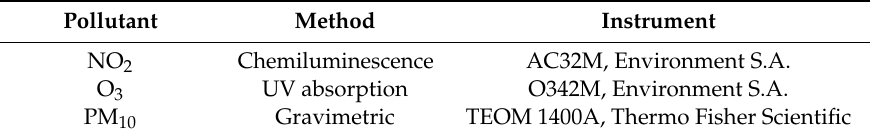
Table 1. Description of the measurement methods and the instruments that have been used to measure the pollutants included in the Air Quality Health Index